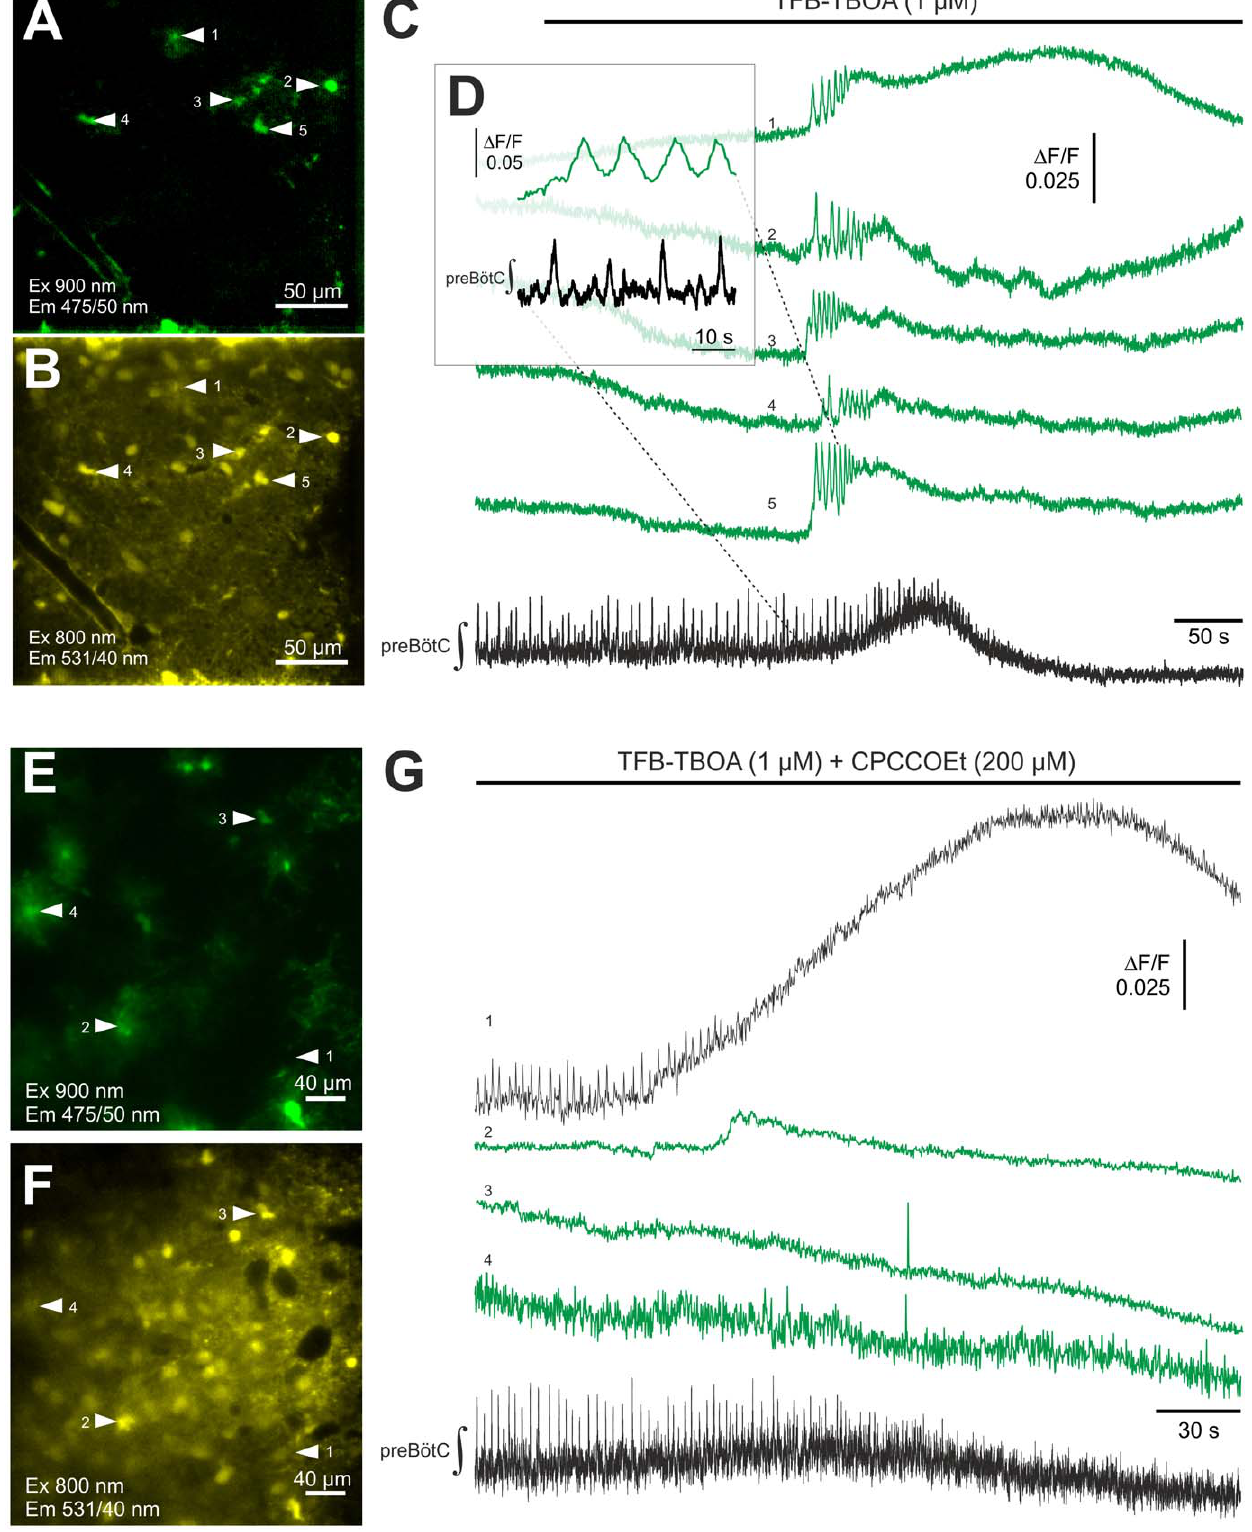
Figure 6. Inhibition of astrocytic glutamate transport elicits robust calcium signals in astrocytes. Panels ( A – D ) show an example of fluorometric calcium imaging during glutamate transport: Panel ( A ) identifies astrocytes, which were loaded with the calcium indicator Oregon Green BAPTA-1 AM (panel B ). ( C ) A blockade of astrocyte glutamate transporters by TFB–TBOA (1 m M) elicited calcium signals in astrocytes (green traces) that were, as shown in ( D ), not phase-locked to preBo¨tC neuronal activity (preBo¨tC 8 ). In the second example ( E–G ) the effects of glutamate transport inhibition are investigated after mGluR1-blockade. When the incubation of the mGluR1-antagonist CPCCOEt (200 m M) was started 10 min before the application of TFB-TBOA the astrocytic calcium signals were suppressed. ( G ) Original OGB-1 AM calcium traces are shown from one respiratory neuron (1) and three astrocytes (green traces). Panel ( E ) shows location of the corresponding EGFP-labeled astrocytes and panel ( F ) the distribution of the OGB-1-AM labeling. doi:10.1371/journal.pone.0026309.g006 PLoS ONE |